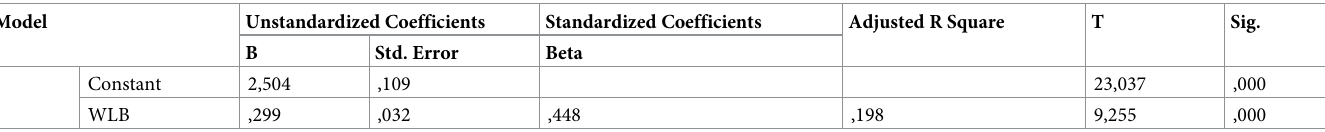
Table 4. Regression coefficient of the impact of work-family balance on employee work engagement.